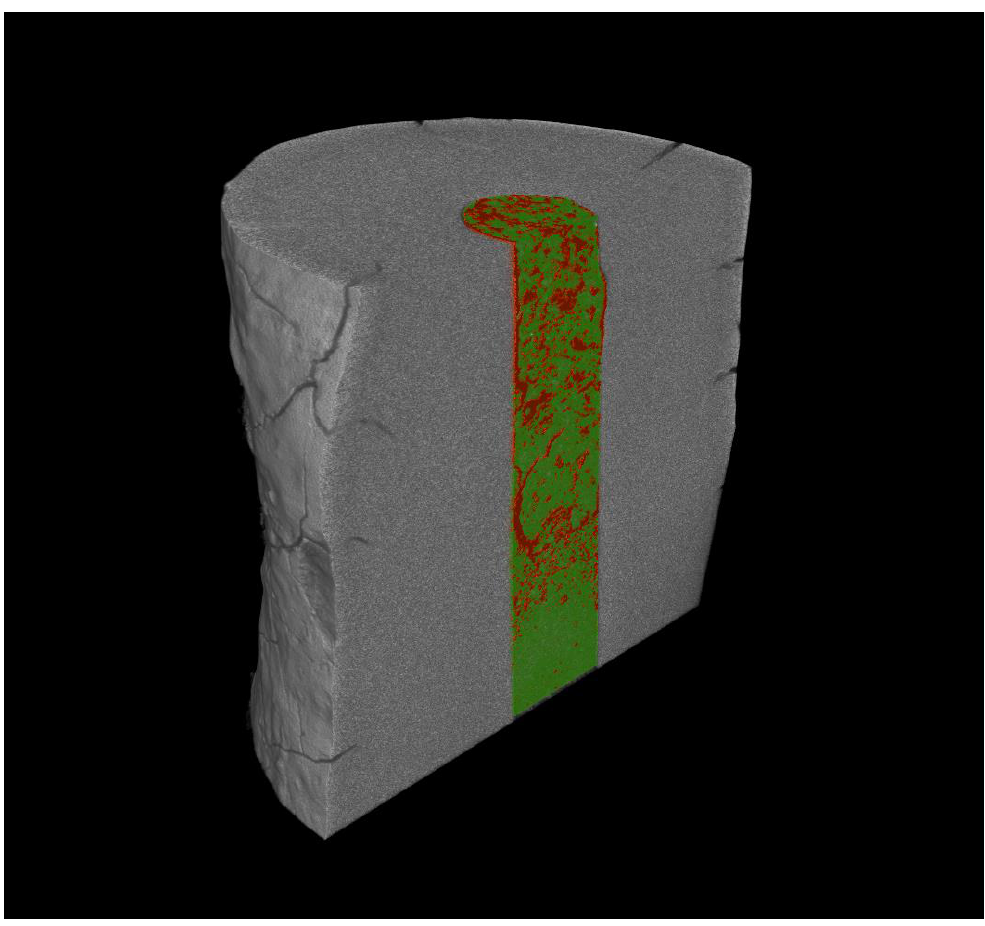
Figure 14. Porosity analysis of BDD-dependent brushite precipitation. Tomographic reconstruction of µCT data and further data processing was carried out using the X-AID software (MITOS GmbH, Garching, Germany). Pores are indicated in red, solid material in green.